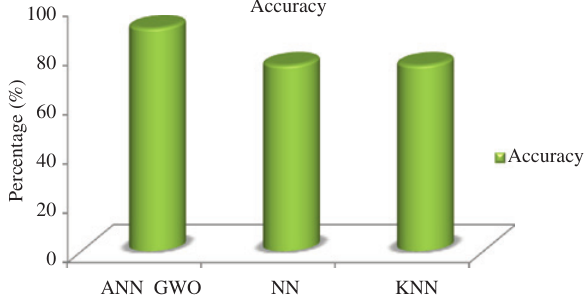
Figure 4: Accuracy Comparison for Different